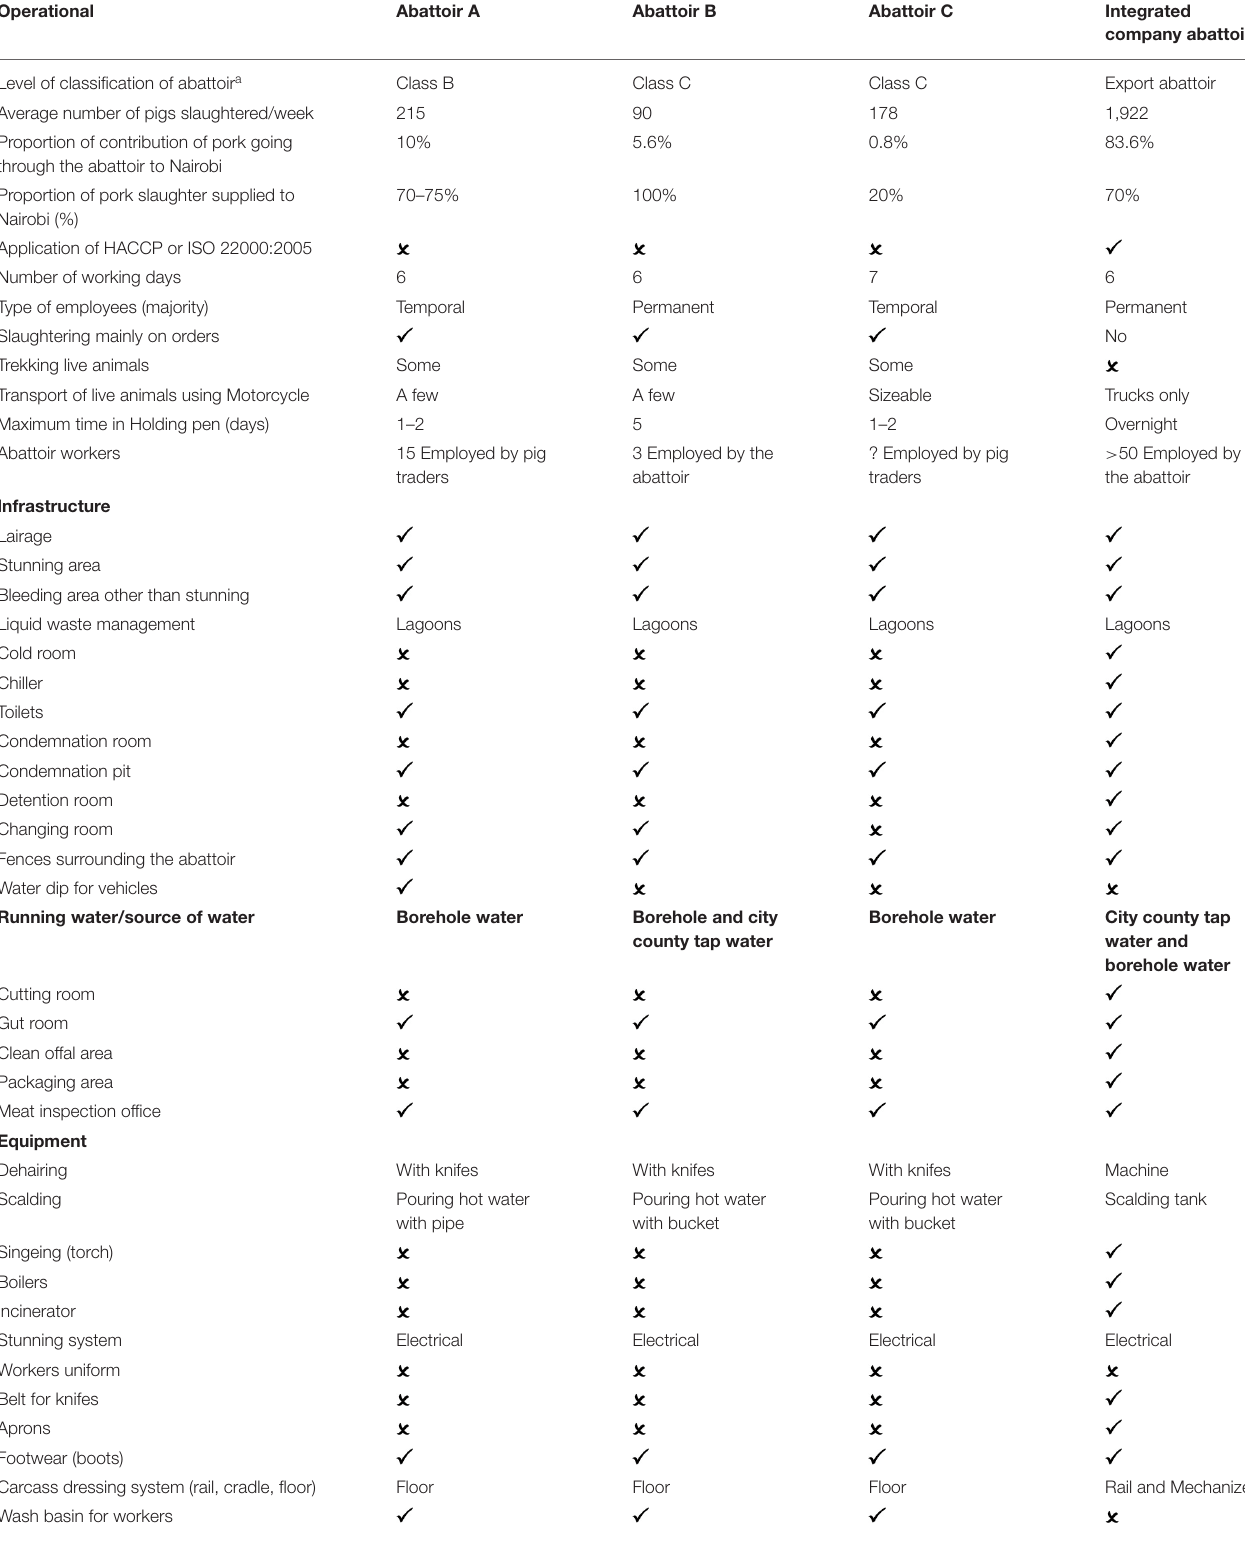
TABLE 2 | Summary for the abattoir’s characteristics.